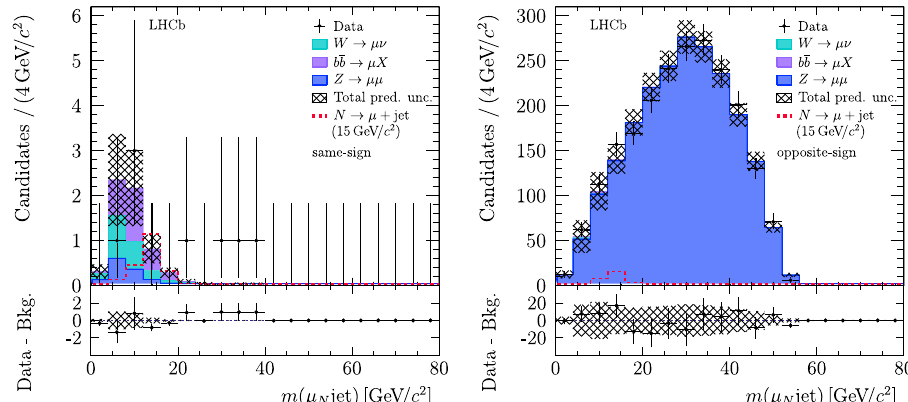
muons, respectively. A single fit to the Run 1 data is per- compatible.Thedistributionsoftheinvariantmass m (μ N jet ) for same-sign and opposite-sign muon data are shown in Fig. 4 with the fits for the 15 GeV/ c 2 neutrino mass hypoth- esis superimposed. Upper limits at 95% confidence level on (cid:2) (cid:2) (cid:2) (cid:2) 2 B ( N → μ jet ) V μ N are set for each heavy-neutrino mass